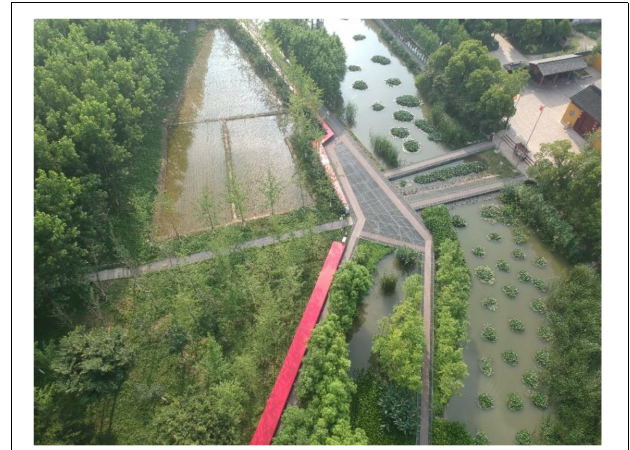
FIGURE 5 | Zhenshan Park after built (Photo taken by